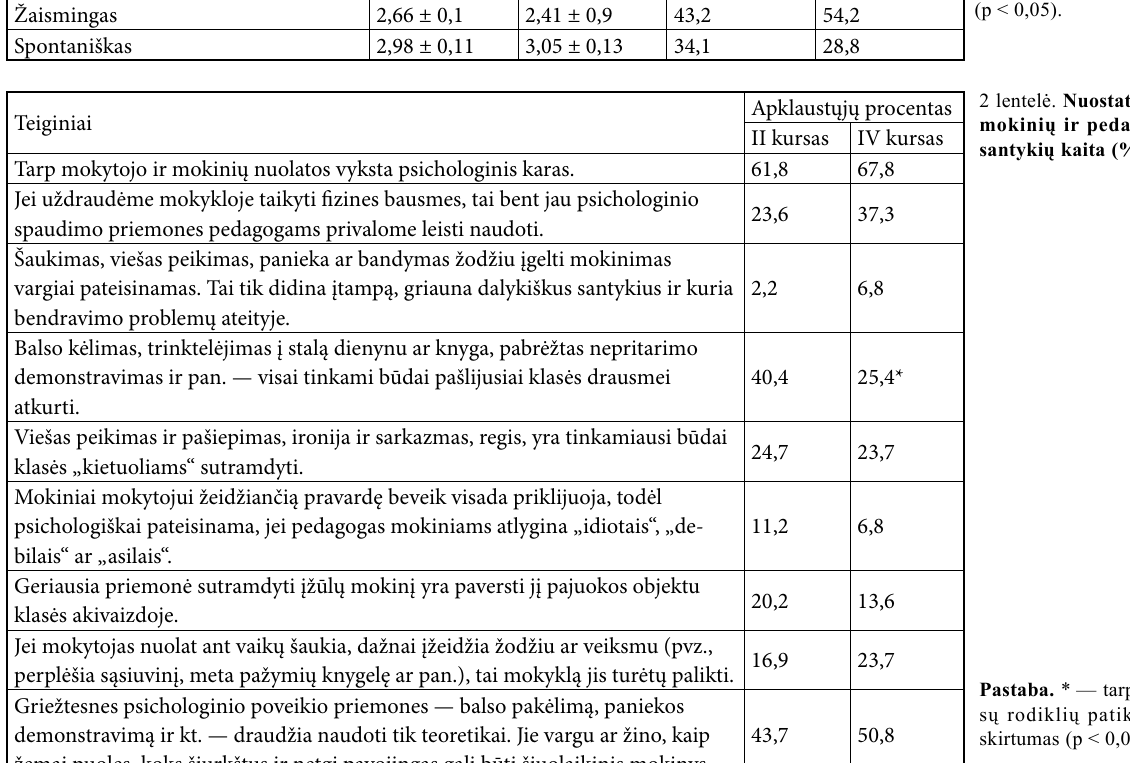
Pastaba. V — duomen ų vidurkis; SP — standar- tin ė paklaida. * — tarp kurs ų rodikli ų patikimas skirtumas (p < 0,05).